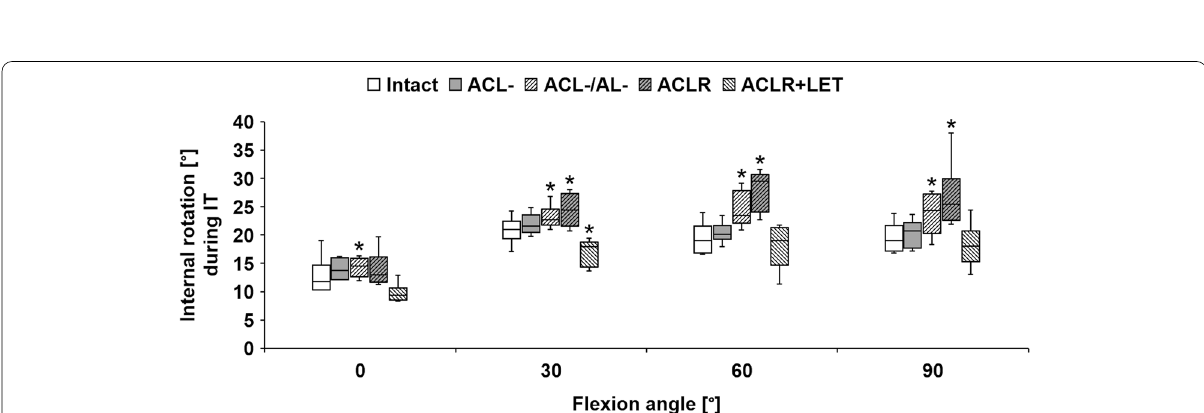
Fig. 8 Tibial rotation during the application of internal tibial torque (IT), in comparison between the intact state, state with resected anterior cruciate ligament (ACL-), state with resected ACL combined with anterolateral rotatory instability (ACL-/AL-), state with ACL reconstruction (ACLR), and state with ACLR and addition of a lateral extra-articular tenodesis (ACLR LET) for different angles of knee flexion. Significant differences from + the intact state are marked with an asterisk (*) for each flexion angle